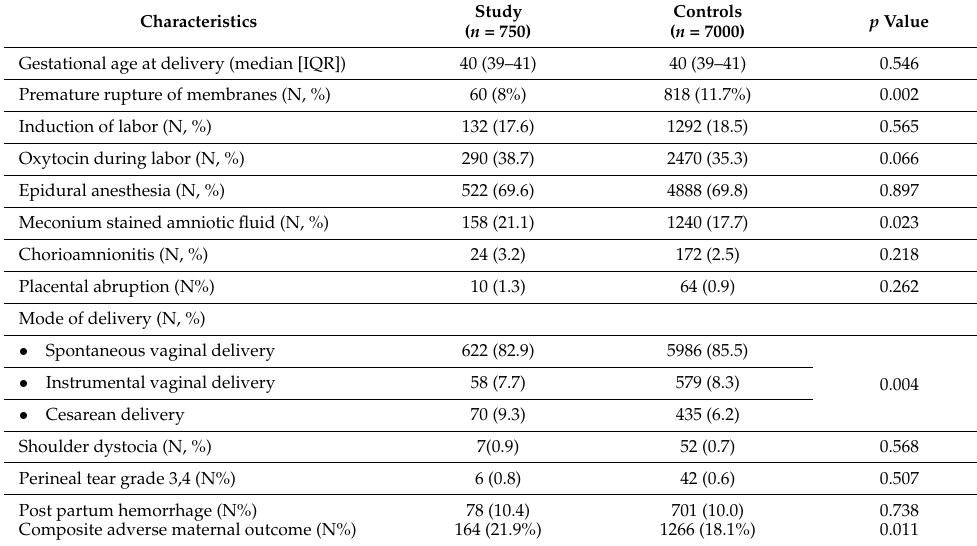
Table 3. Labor Characteristics.